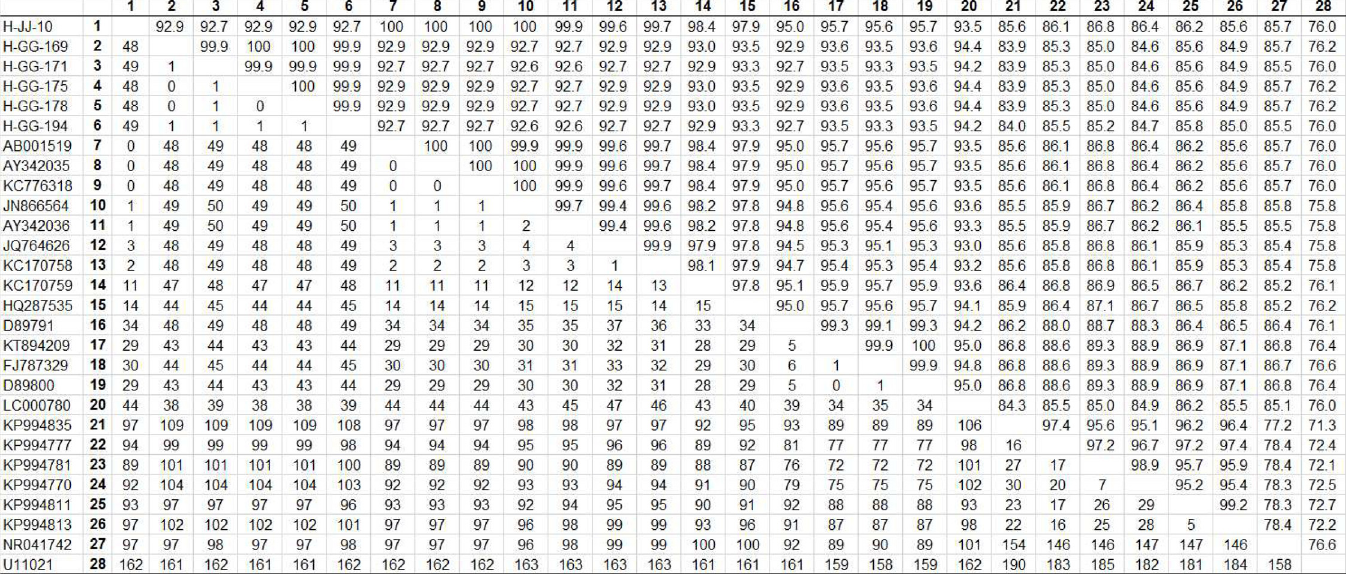
Fig 2. Comparison of Coxiella 16S rRNA nucleotide sequences. The upper matrix shows percent identity between the partial sequences of the Coxiella 16S rRNA gene. The lower matrix presents the number of differences in nucleotide